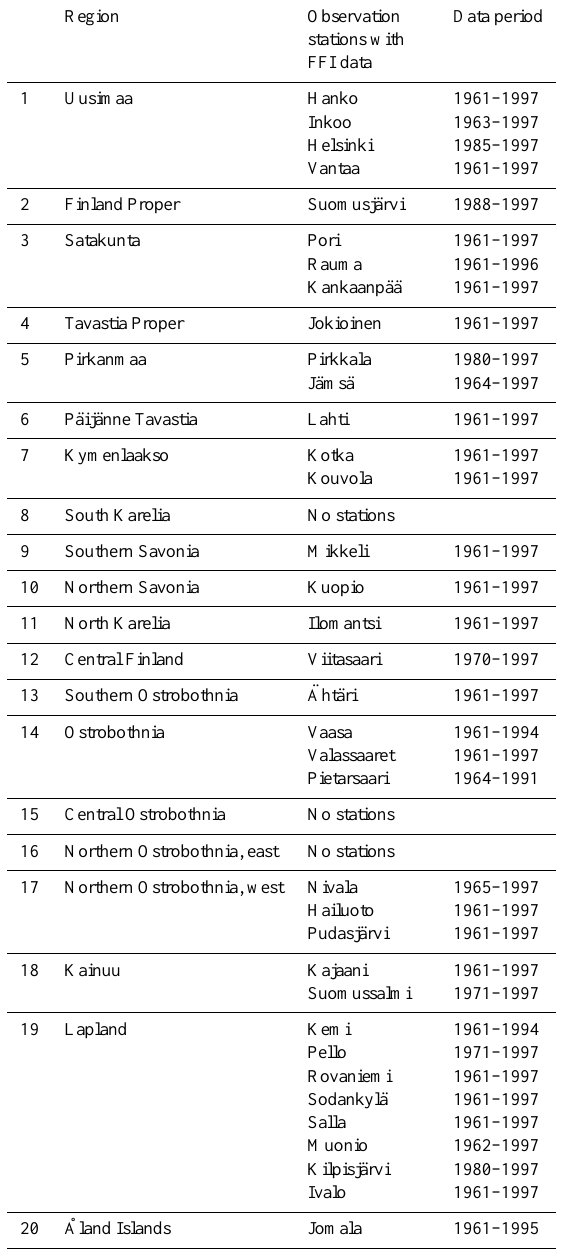
Table 1. Scaling of the volumetric moisture content (%) into classes of surface wetness and forest fire index (FFI). Table adapted from Vajda et al. (2012).